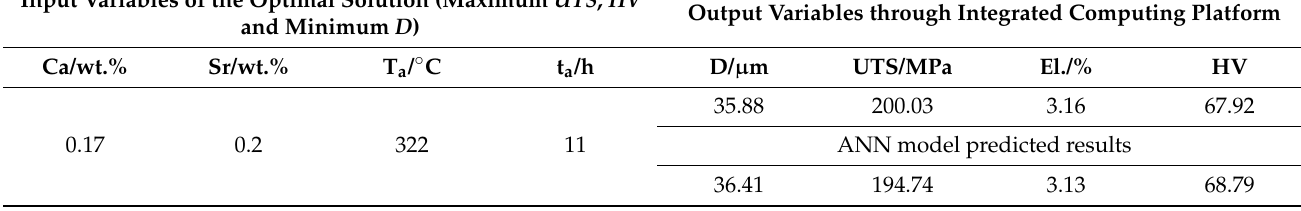
Table 6. The optimal solution and results of model validation.